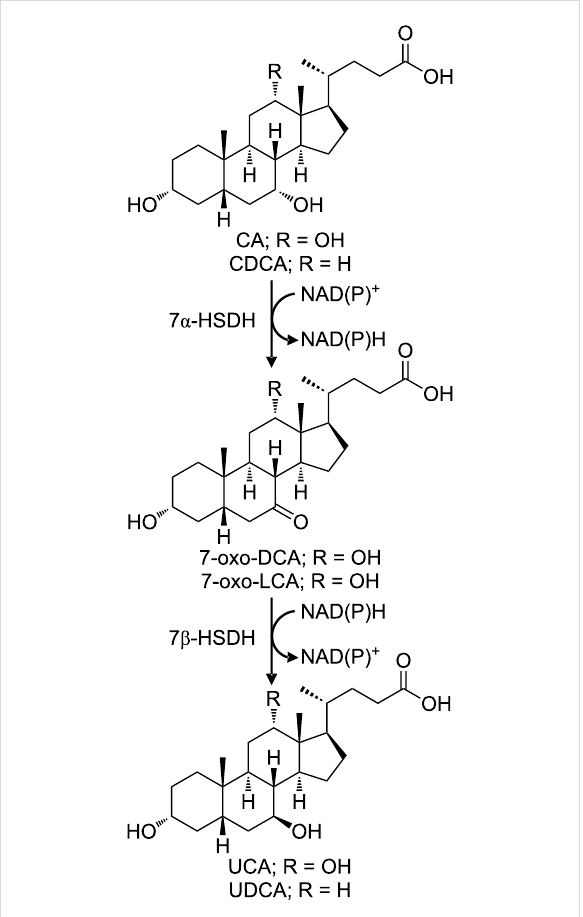
Figure 5: Epimerization reaction catalysed by the 7 α -HSDH and 7 β -HSDH; the 7 α -OH group of CA (R = OH) or CDCA (R = H) is firstly oxidized by the 7 α -HSDH yielding 7-oxo-DCA or 7-oxo-LCA, respec- tively. Subsequently, the keto group is reduced by the 7 β -HSDH giving the final products UCA or